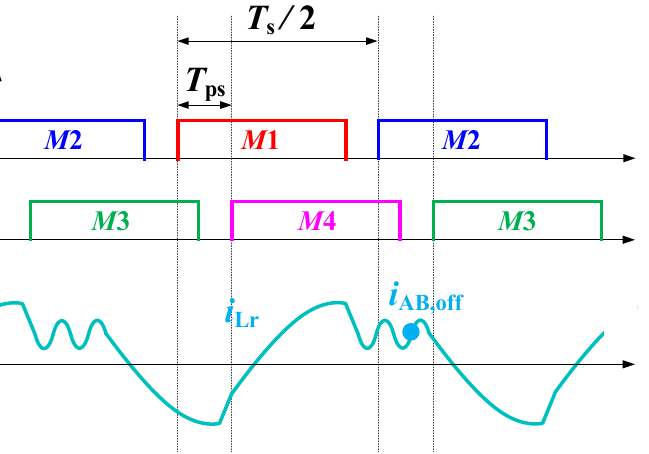
Figure 17. Schematic diagram using fixed-frequency phase-shift strategy in step-down mode. In Figure 17, as the turn-off current of the leading leg, M 1 and M 2 , is higher than that of the lagging leg, M 3 and M 4 , in order to guarantee ZVS of four MOSFETs, the dead time of the HVS MOSFETs should meet the requirement